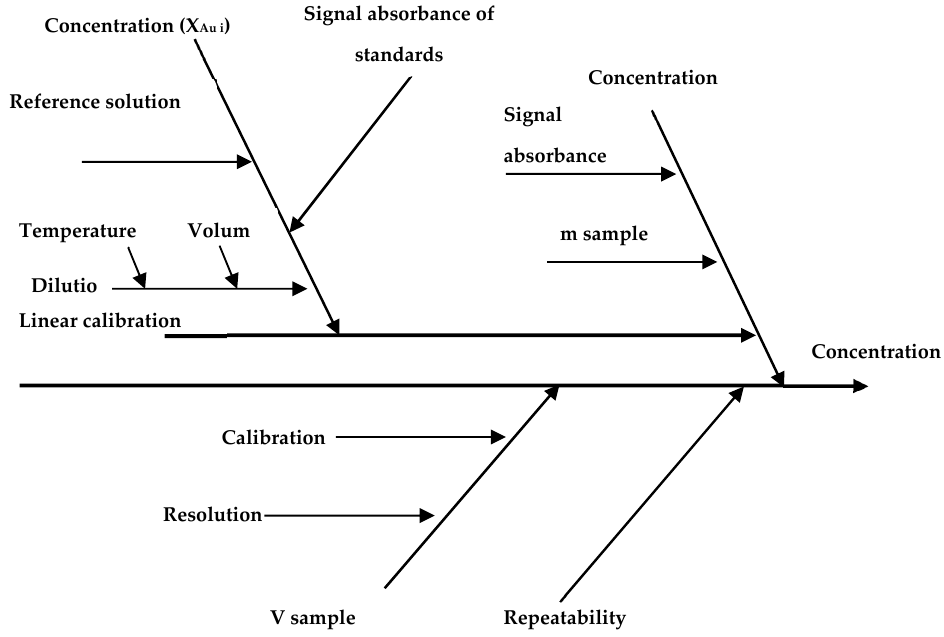
Figure 2. Cause and effects diagram (Ishikawa diagram) of uncertainties in the measurement of Au in biological tissue using GFAAS.